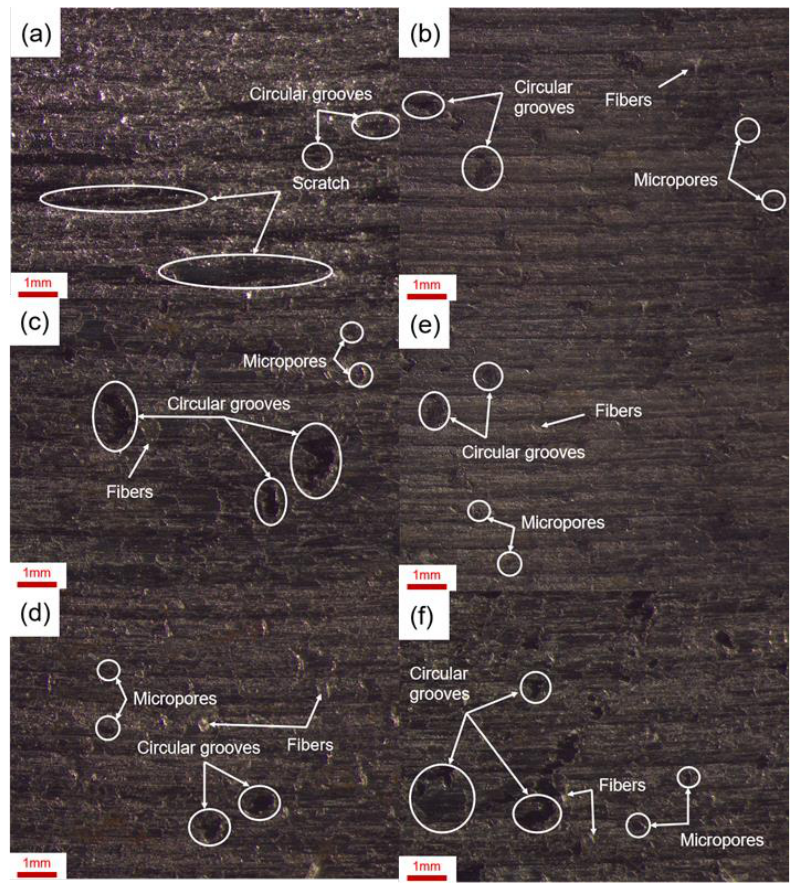
Figure 10. Worn disk surfaces with various particle sizes under lubricating grease condition: ( a ) no powder added; ( b ) 0.17 mm; ( c ) 0.28 mm; ( d ) 0.43 mm; ( e ) 0.56 mm; ( f ) 0.90 mm.